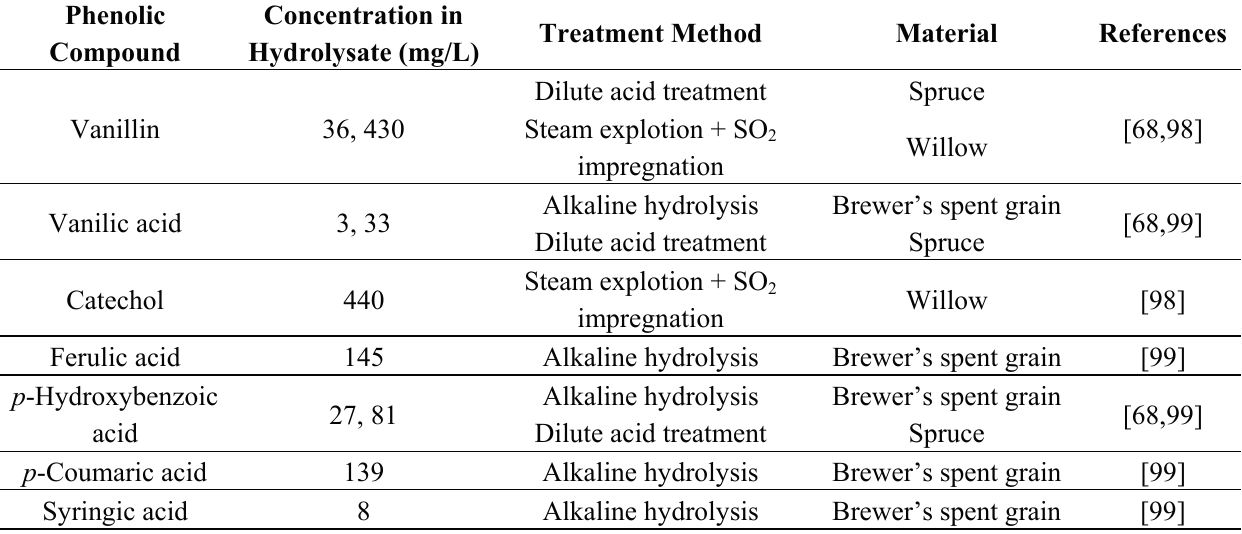
Table 3. Phenolic compounds in hydrolysates from lignocellulosic